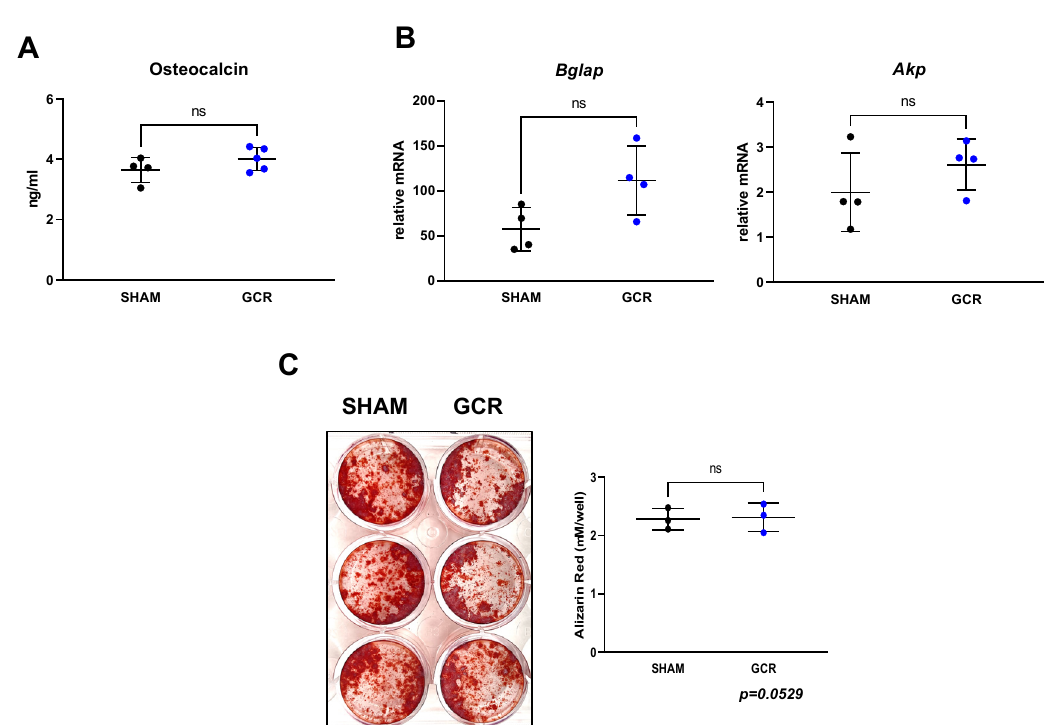
Figure 5. Osteoblast differentiation was not affected by GCR exposure at 3 months. ( A ) Serum marker of OB differentiation, osteocalcin, was measured by ELISA and found to be unchanged in GCR exposed mice (compared to the sham-irradiated group). ( B , C ) Bone marrow stromal cells were isolated from 9-month-old mice 3 months after 0.5 Gy GCR exposure and cultured with ascorbate (50 mg/mL) and β -glycerophosphate (10 mM) for 14 days for OB differentiation. Assessment of neither mRNA levels of OB differentiation markers ( B ) nor the number of differentiated OBs in vitro ( C ) demonstrated any significant differences between sham-irradiated and GCR exposed groups. Representative images of Alizarin Red stained OBs can be seen in panel C. Data are presented as ± SD. p values were determined using Student’s t -test. (n = 3–4, n.s.: not significant).